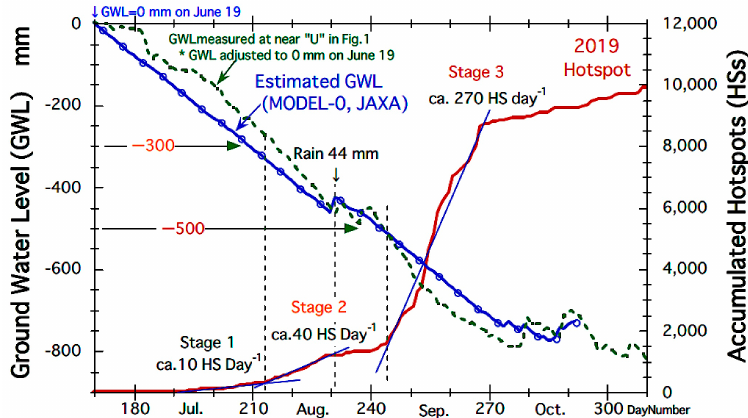
Figure 11. Fire trend and estimated GWL in 2019. Rainfall data from JAXA, GWL for MODEL-0 on June 19 (DN = 170) were set to 0 mm. GWL measured is adjusted to 0 mm on June 19. GWL data measured at near ‘U’ in Figure